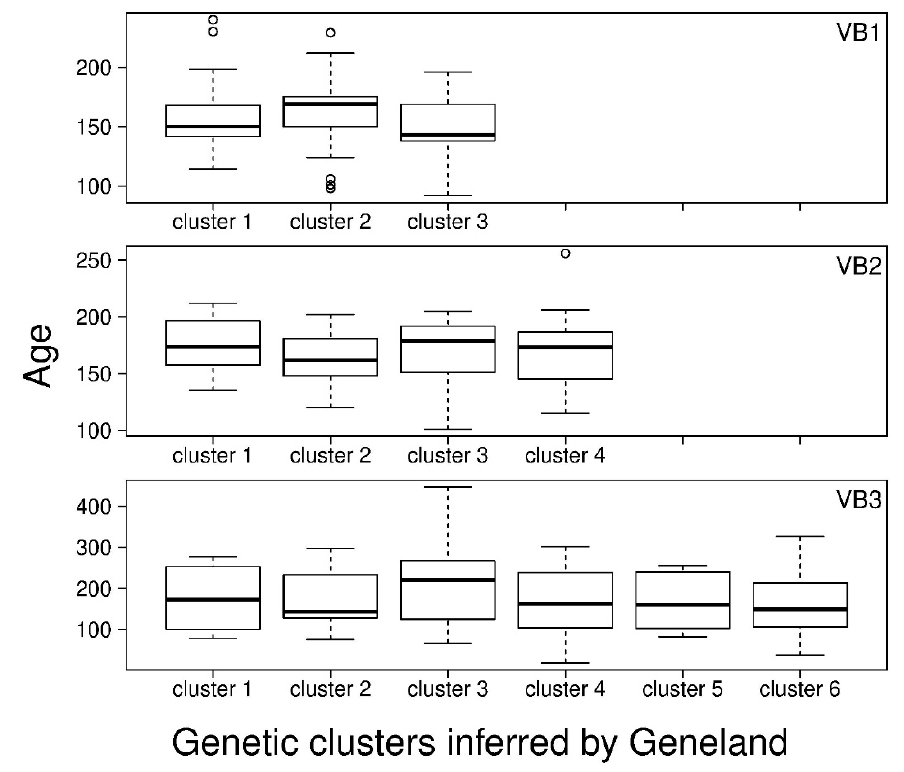
Figure 5. Age distribution within the genetic clusters inferred by Bayesian clustering in the three 1-ha plots.